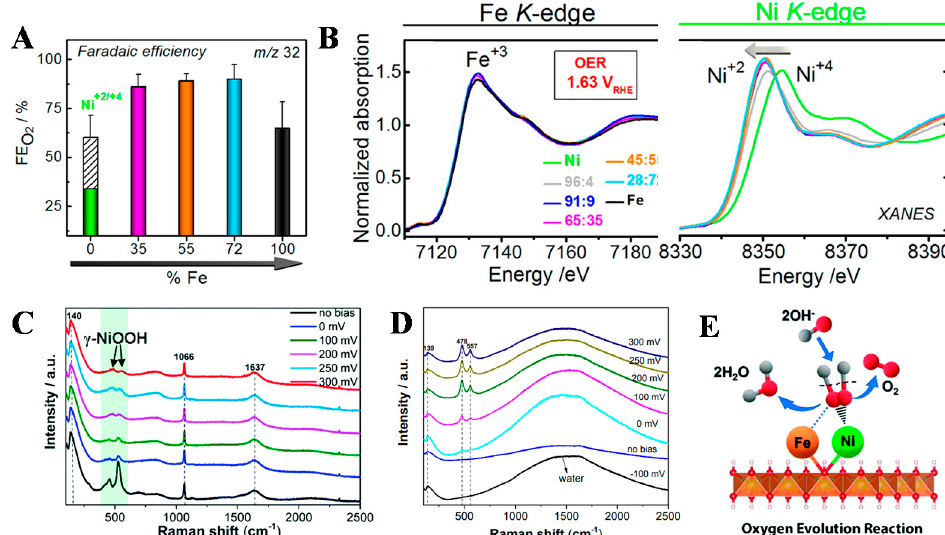
Figure 4. ( A ) Faradaic O 2 efficiencies of NiFe oxyhydroxide catalysts as a function of Fe-content (Ni 100 − x Fe x ) given as atomic%. The hatched bar represented the O 2 efficiency excluding the charge associated with Q F,Ni+2/+3 , corresponding to the Ni(OH) 2 /NiOOH redox process. The Faradaic O 2 efficiency was derived from FE O2 (%) = Q F,O2DEMS /QF tot ; ( B ) X-ray absorption spectra of the NiFe catalysts with varying catalyst composition (Ni 100 − x Fe x ) freeze-quenched under application of catalytic potential after conditioning at 1.63 V for 30 min in 0.1 M KOH [123]. Copyright © 2016 American Chemical Society. ( C ) In situ Raman spectra collected in a large wavenumber region from NiFe-LDHs during OER process in 1 M KOH at various overpotentials vs. RHE; ( D ) In situ Raman spectra collected in 1 M KOH with different applied overpotentials vs. RHE from − 100 mV to 300 mV for Ni(OH) 2 on Ni foam. The peaks appeared at ~478 ± 1 and ~557 ± 1 cm − 1 , indicating the transformation of Ni(OH) 2 to NiOOH during oxygen evolution reaction in alkaline media; ( E ) the OER mechanism of NiFe LDH: OH − from the aqueous electrolyte was adsorbed on the Ni 2+ center at modest overpotentials ( η ~200–300 mV), forming OH ad intermediate on the Ni site [127]. Copyright © The Royal Society of Chemistry 2019.